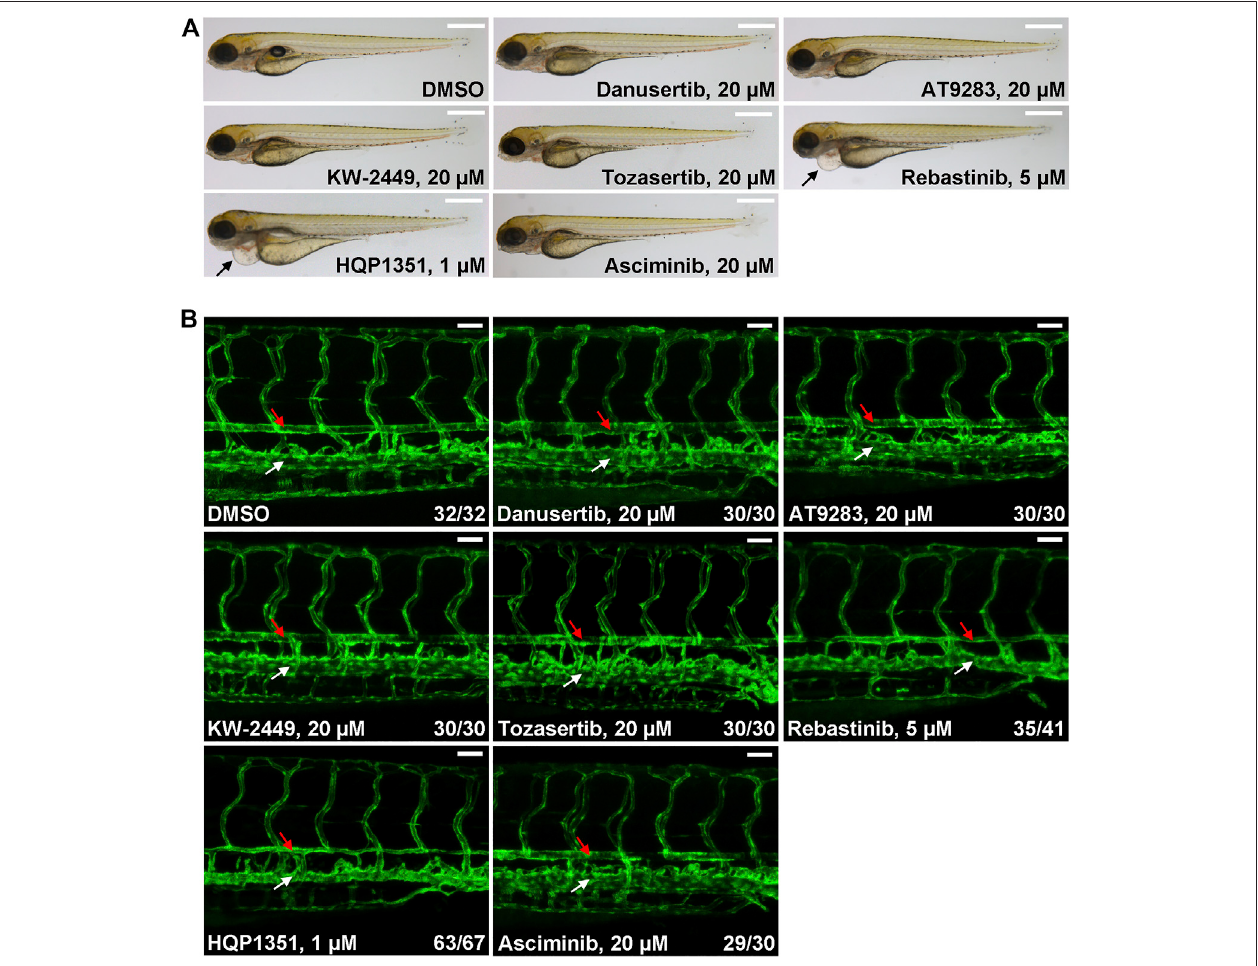
FIGURE 3 | Evaluation of potential cardiovascular toxicity of clinical stage TKIs that are ef fi cacious against T315I. (A) Morphology of embryos treated with the indicated TKIs at 4 dpf. Assays were performed as described in Figure 1A . Arrows indicate cardiac edema. Scale bar: 500 µm. (B) Confocal imaging of vessel phenotypes of embryos treated with the indicated TKIs. Embryos were treated and analyzed as describe in Figure 1B . Red arrow: dorsal aorta; white arrow: posterior cardinal vein. Numbers are the sum of two independent biological repeats. Scale bar: 50 µm.